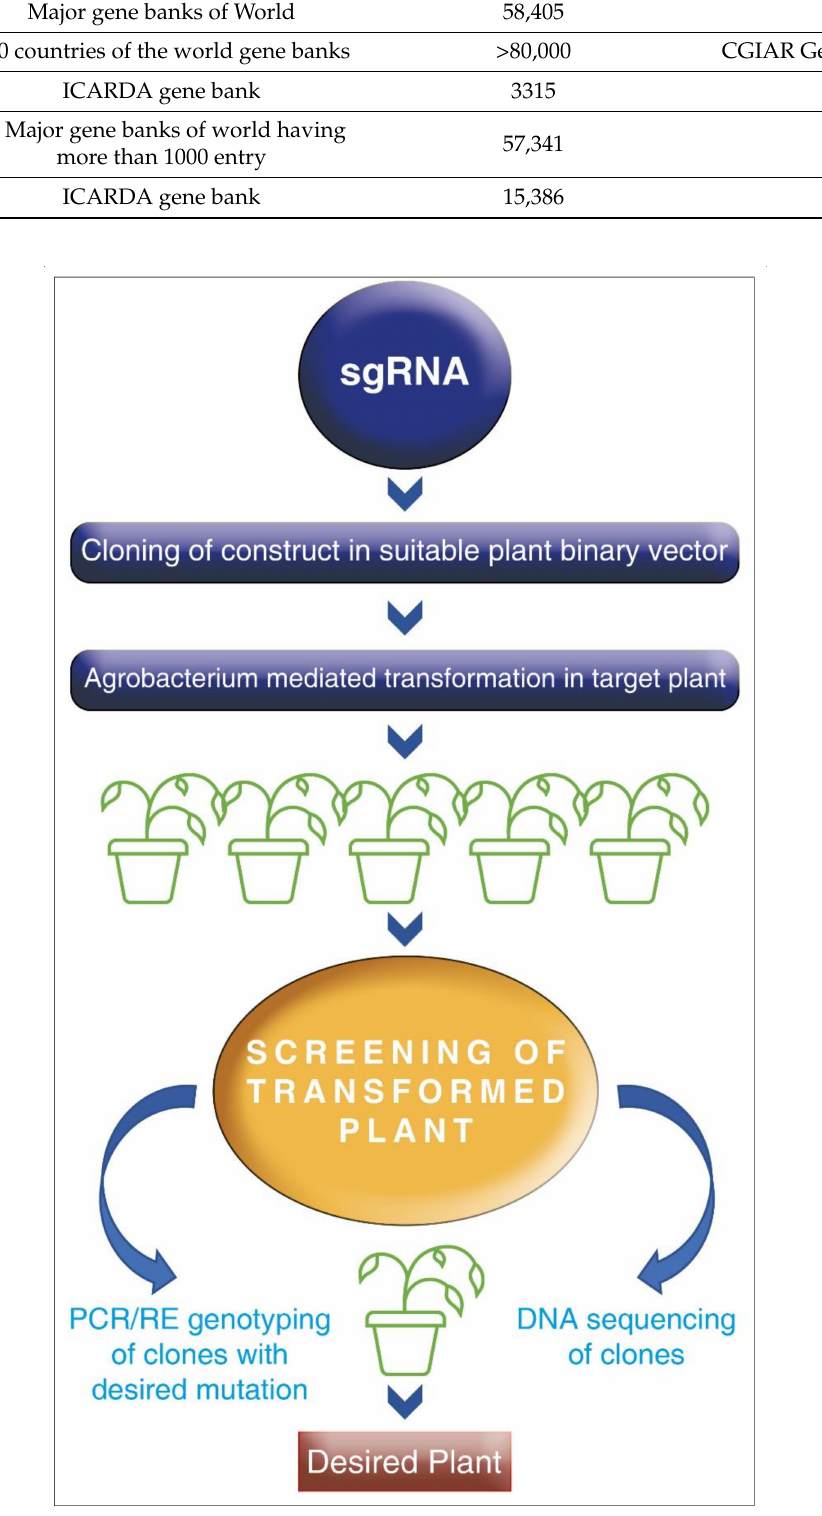
Figure 3. Schematic representation of genome editing (GE) using